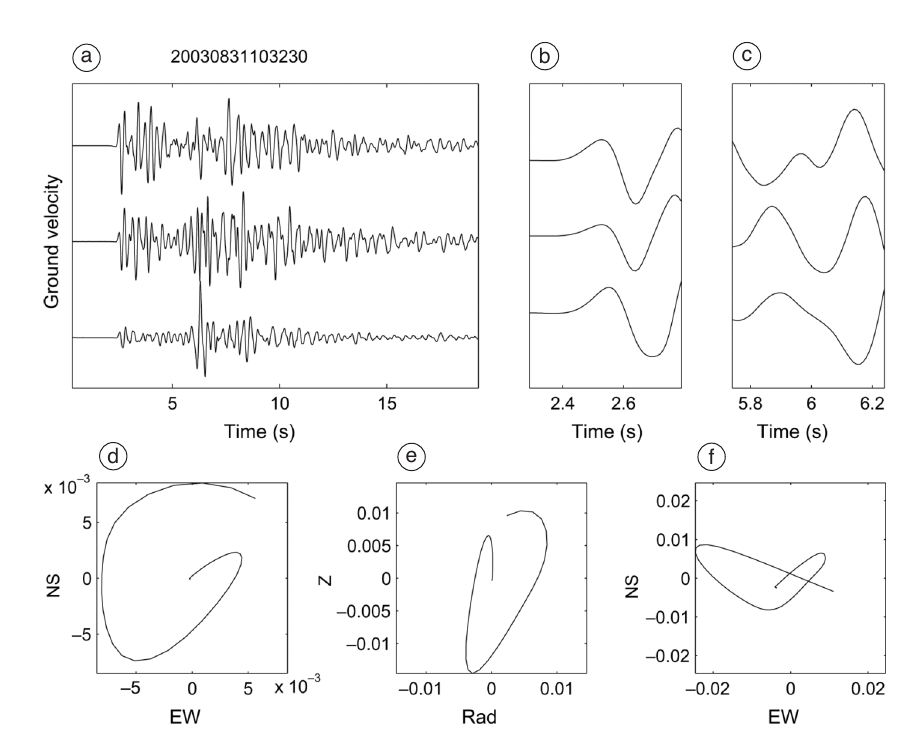
Fig. 9a-f. a) Three-component, array-stacked waveforms for the same event displayed in figs. 7a-e and 8a-e. b, c) Time windows respectively used for P - and S -wave polarization estimates. d, e) P -wave particle motion or- bits over the horizontal and radial-vertical plane, respectively. f) S -wave particle motion over the horizontal plane. P- wave polarization azimuth and incidence angles obtained from the covariance analysis are 35° and 12°, respectively. The S -wave polarization azimuth is